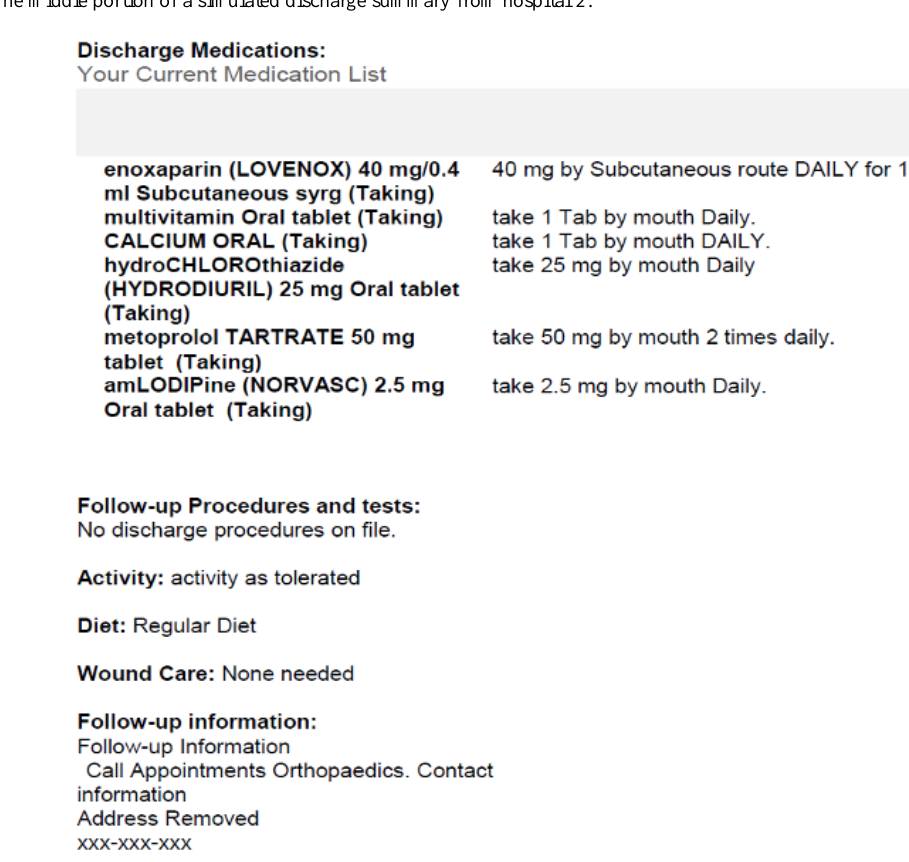
Figure 2. The middle portion of a simulated discharge summary from hospital